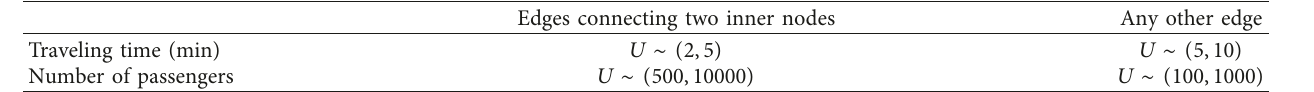
Table 2: Traveling times.